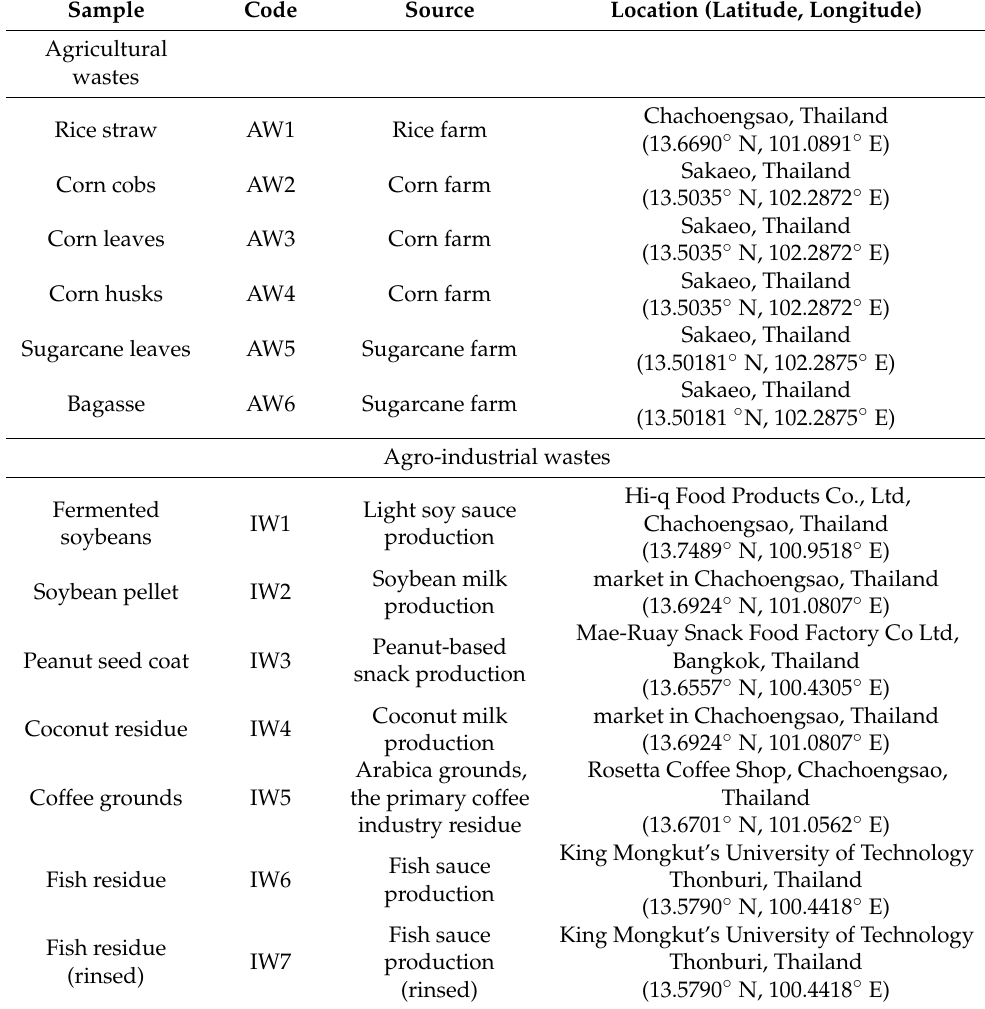
Table 1. Waste sample